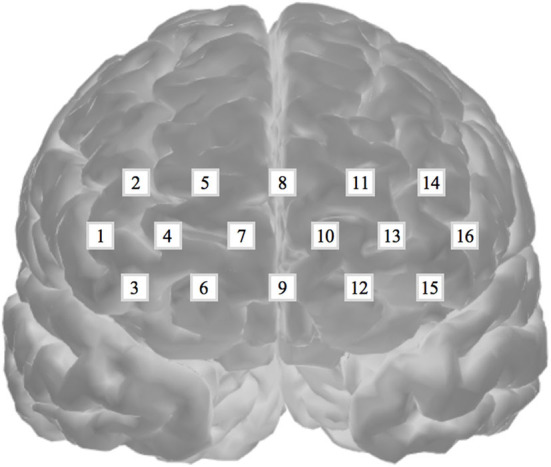
Spectratech OEG-16. The locations of the 16 fNIRS channels along the frontal cortex. The center of the measurement unit was placed on the frontopolar (Fp) region according to the international 10–20 system.